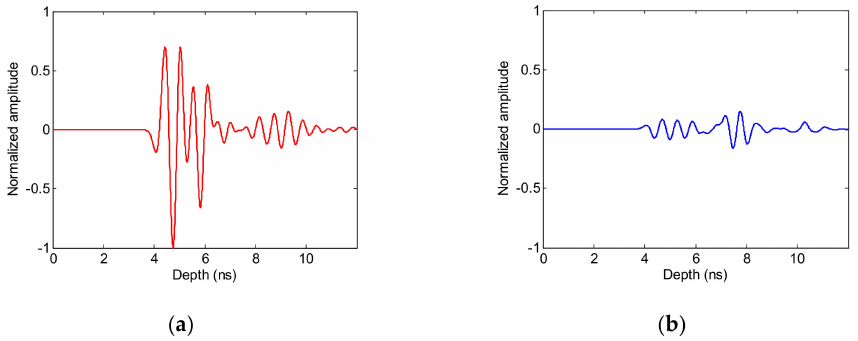
Figure 14. A-scan data: ( a ) disease data, and ( b ) non-disease data.